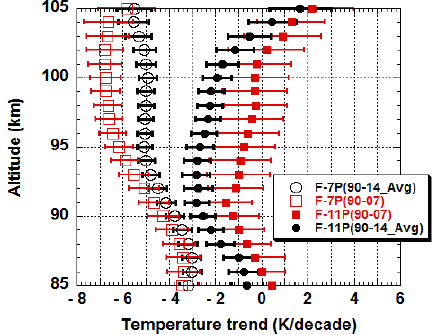
Figure 2. Linear temperature trend from the quarter century data set with 11- and 7-parameter analyses, respectively denoted as F- 11P(90-14_Avg) in black solid circles and F-7P(90-14_Avg) in black open circles. Shown for comparison are those data published based on an 18-year data set denoted as F-11P(90-07) in red solid squares and F-7P(90-07) in open red